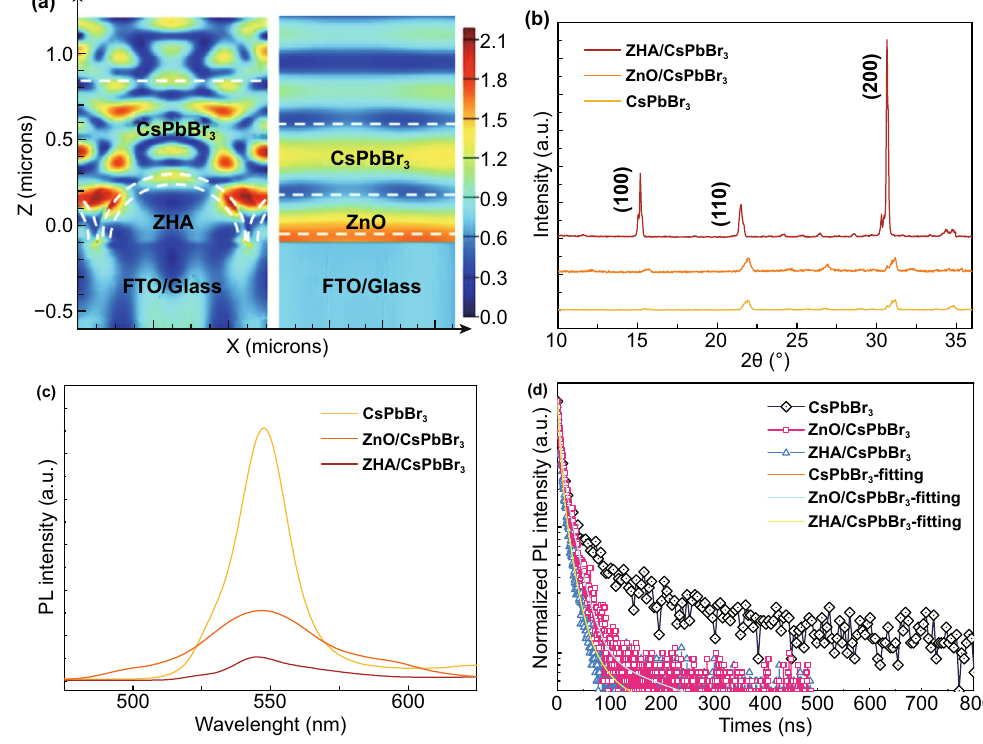
Fig. 3 a FDTD Simulation of ZHA (left) and planar (right) devices under 550 nm illumination and b X-ray diffraction pattern, c steady PL, and d transient PL based on devices with different